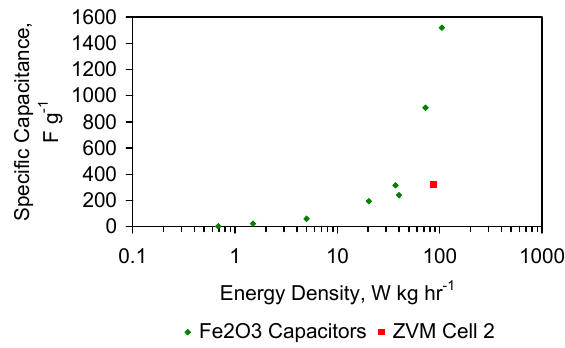
Figure 12. Energy densities and specific capacitance recorded by Fe 2 O 3 :C composite capacitors. Reference Data Sources: [121–142]. ZVM Cell 2 = unused ZVM TP prior to use for desalination.